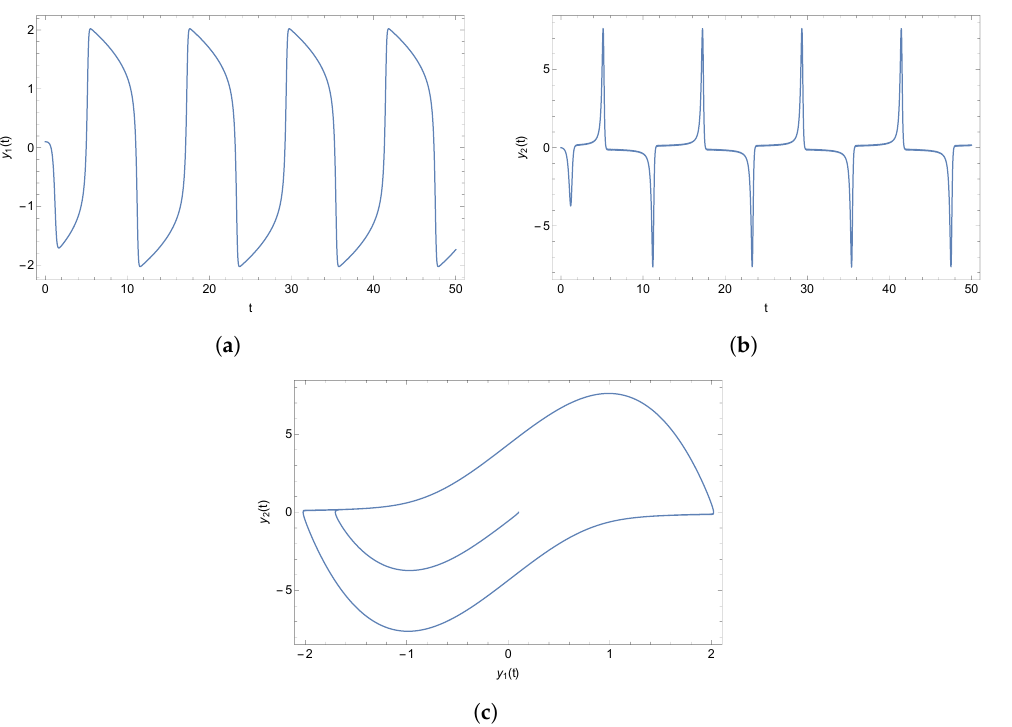
Figure 7. Solution profile of the van der Pol oscillator example when h = 0.01. ( a ) y 1 ( t ) vs. t . ( b ) y 2 ( t ) vs. t . ( c ) Phase